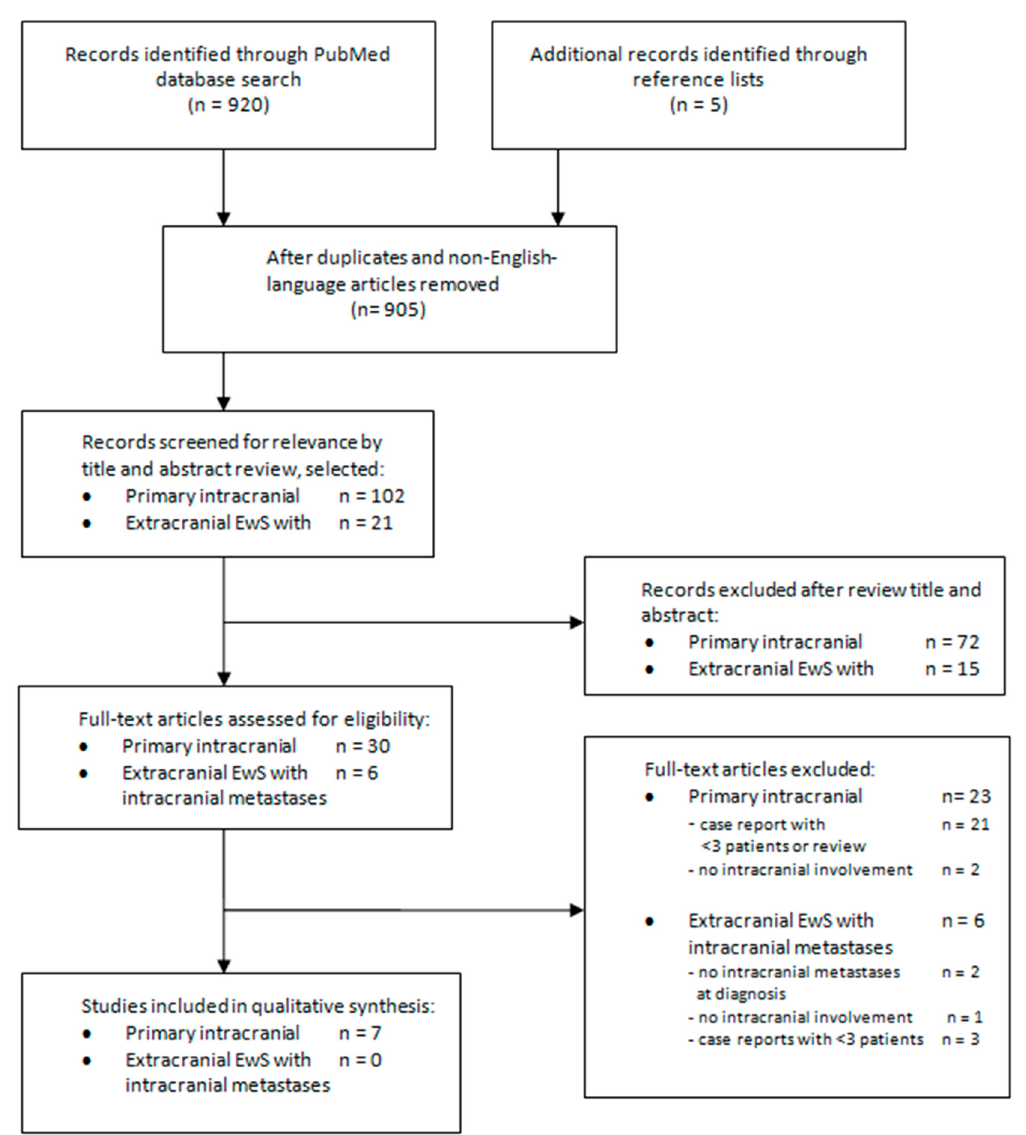
Figure 2. The process of publication retrieval, and the inclusion and exclusion of studies .